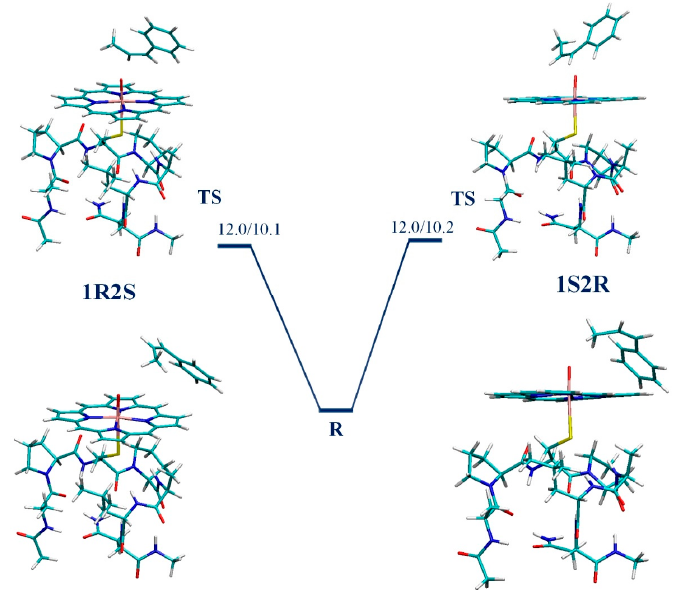
Figure 4. The UB3LYP/B1//B0 potential energy surfaces (in kcal/mol) connecting the reactant states R and the rate-limiting transition states TS leading to the formation of a C β –O bond on the doublet potential energy surfaces for 1R2S and 1S2R epoxidation of CBMS by CPO-I-B.